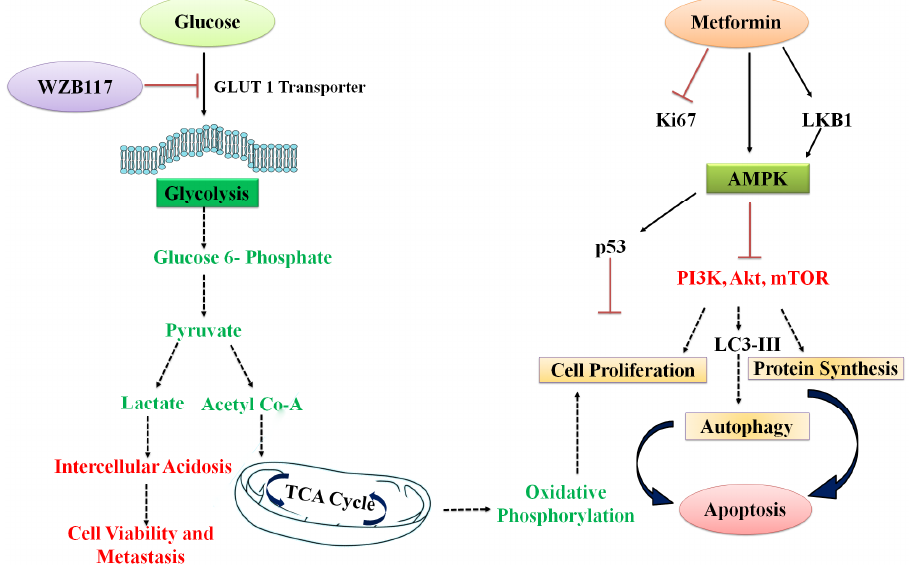
Figure 1. Combination of metformin and WZB117 for anti-cancer therapy: WZB117 inhibit the glucose transport to the cancer cells and create the energy stress by targeting extracellular GLUT1 pathway. Metformin inhibits the cell proliferation and protein synthesis by blocking mTOR, Akt, and PI3K pathway and induced apoptosis. The combination synergistically target GLUT1 and AMPK pathway to target the cancer cell apoptosis.